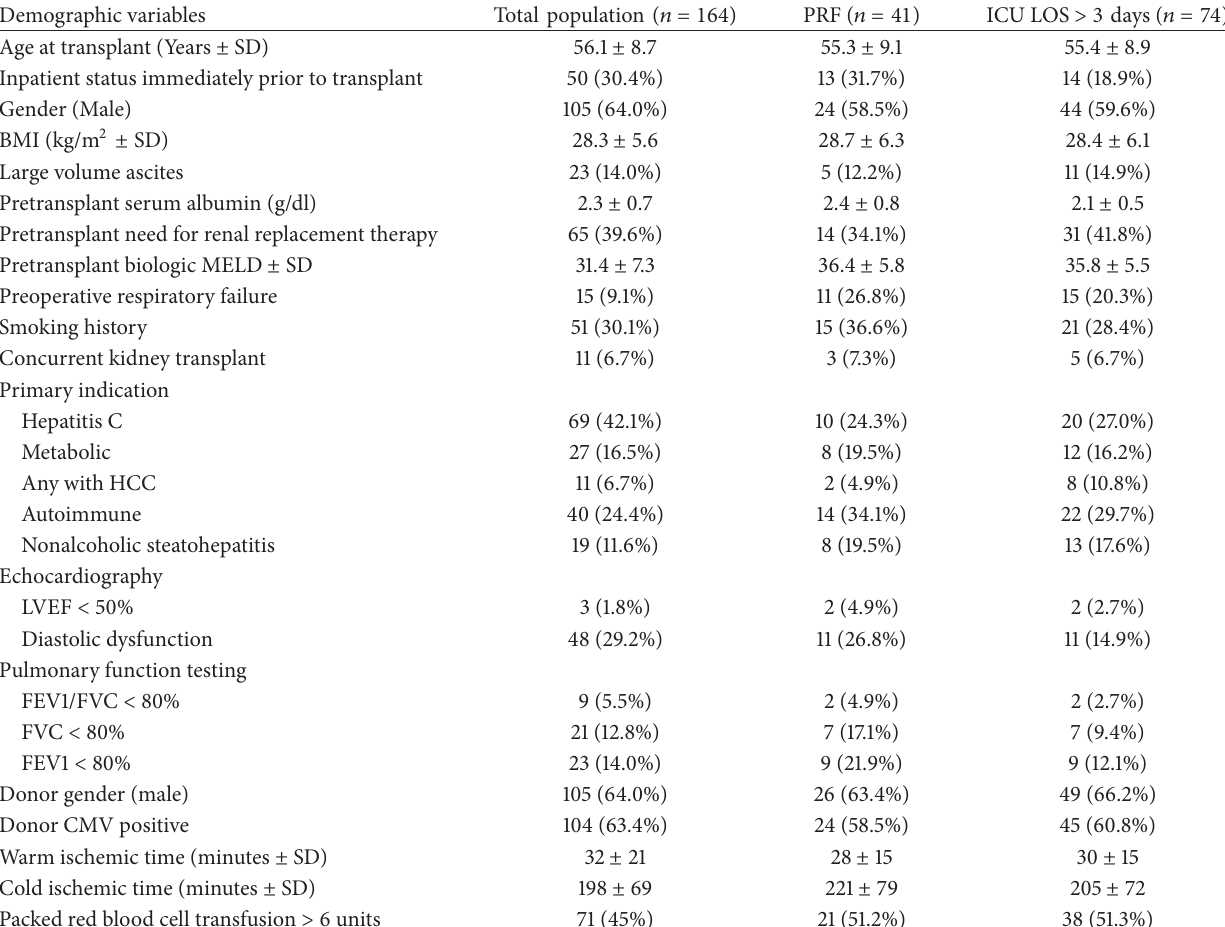
Table 1: Baseline demographic